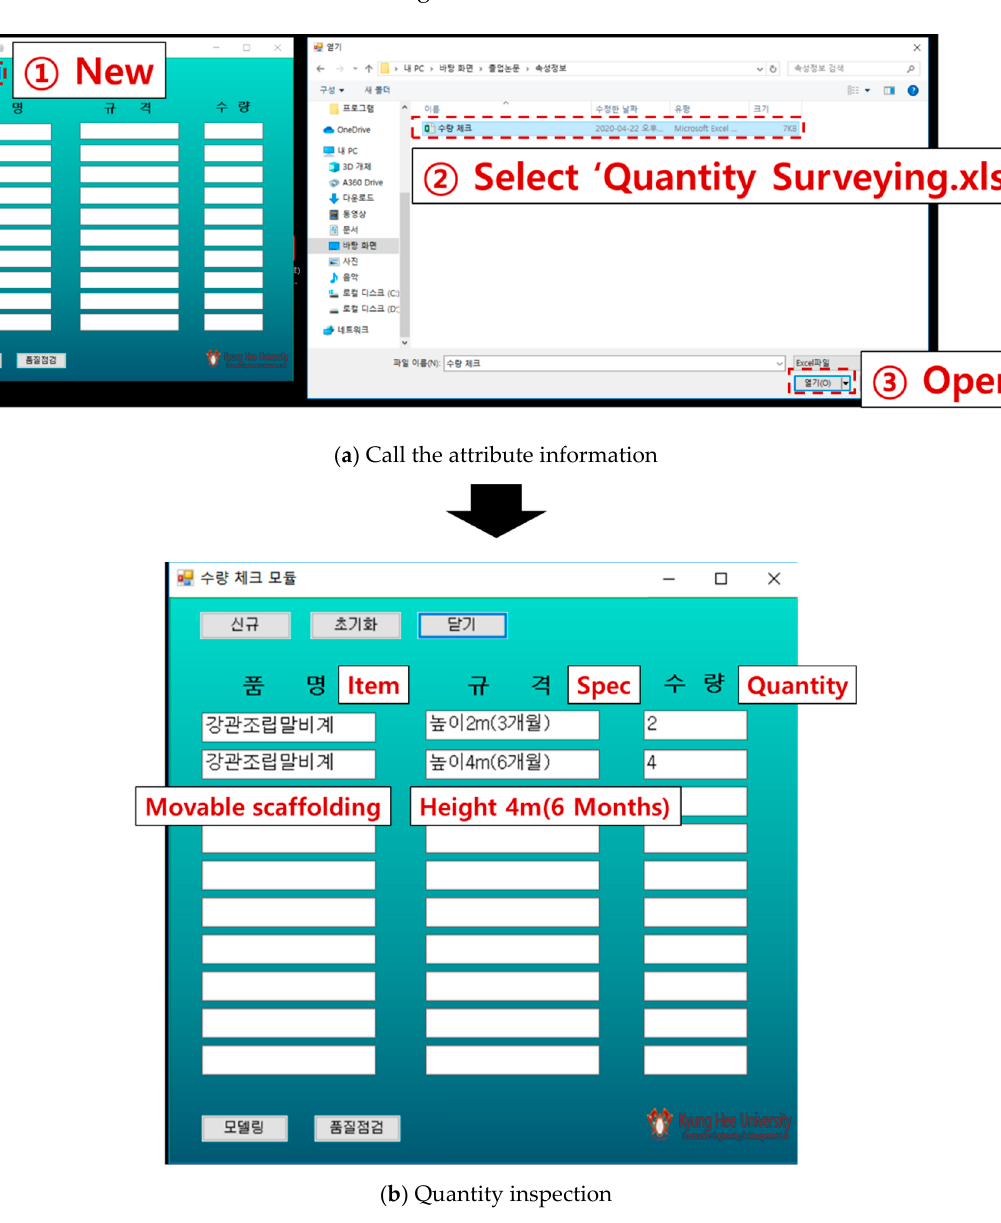
Figure 10. Calling the attribute information that pertains to the temporary facilities quantity and checking the quantity.